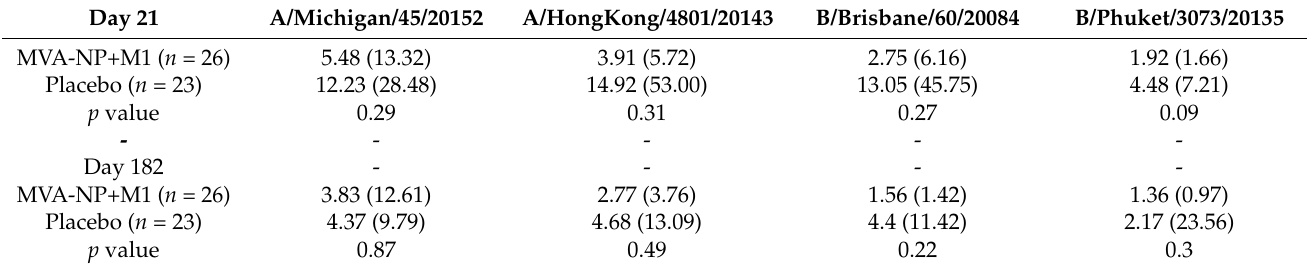
Figure 4. Influenza-specific hemagglutination geometric mean titers to the 2017 vaccine components (H1N1, H3N2, B Brisbane and B Pukhet) in the MVA ( n = 26) and placebo recipients ( n = 23) (SD and p values shown in Table 4); all participants received inactivated influenza vaccine. Table 4. Increase in geometric mean titer between Day 0 and Day 21 in the immunogenicity sub-study for the two experimental groups.